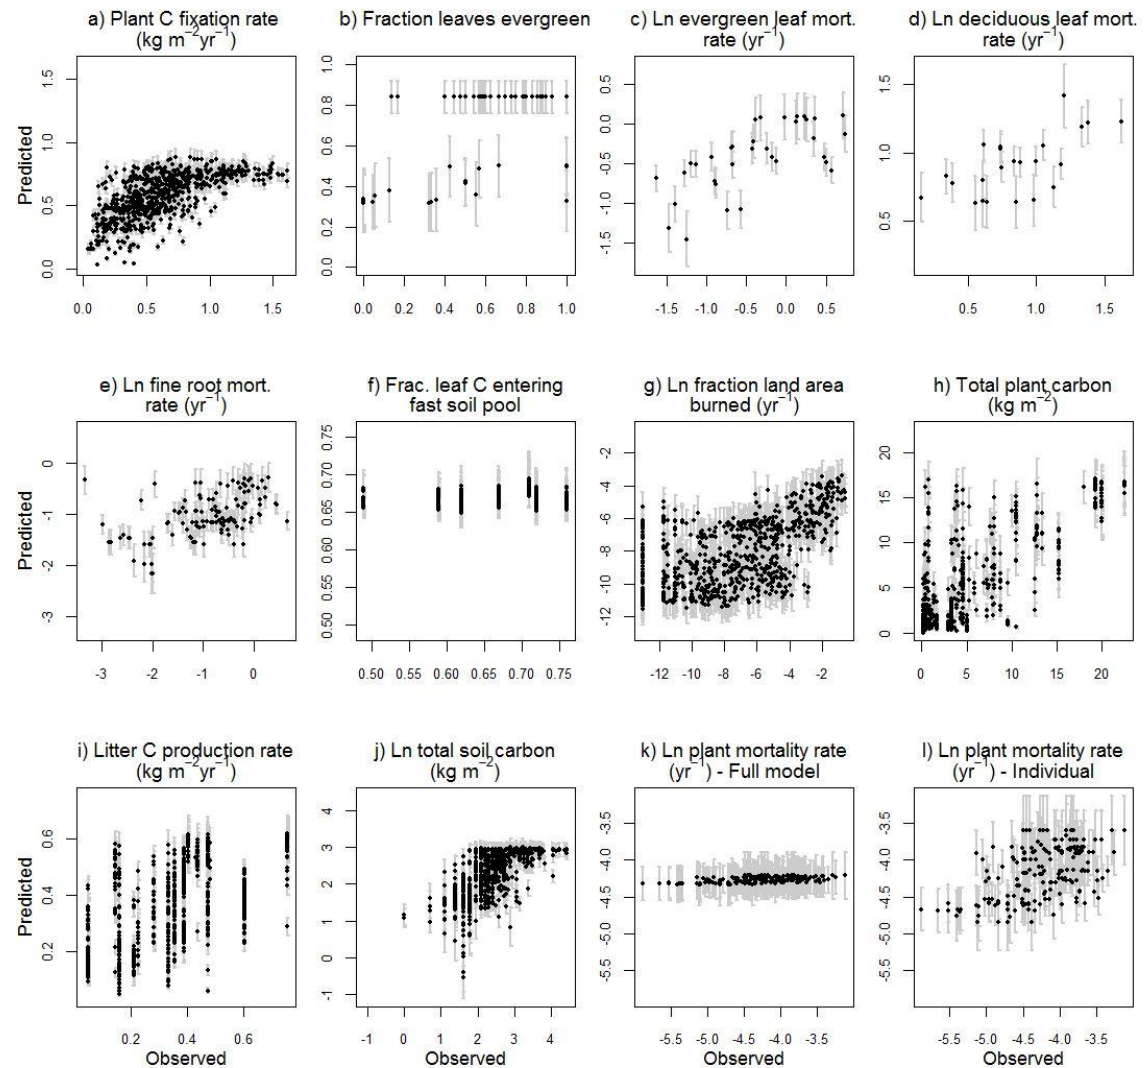
Fig. 6. Model predictions versus observed empirical data (omitting the 25% final test data). Predictions were made using all 10 posterior parameter probability distributions from 10-fold model fitting. Points show the average median prediction, and error bars show the average upper and lower 95% confidence intervals. (a–k) show predictions from the full model trained to all empirical data sets, and (l) shows predictions from the plant mortality model trained to the plant mortality data alone.